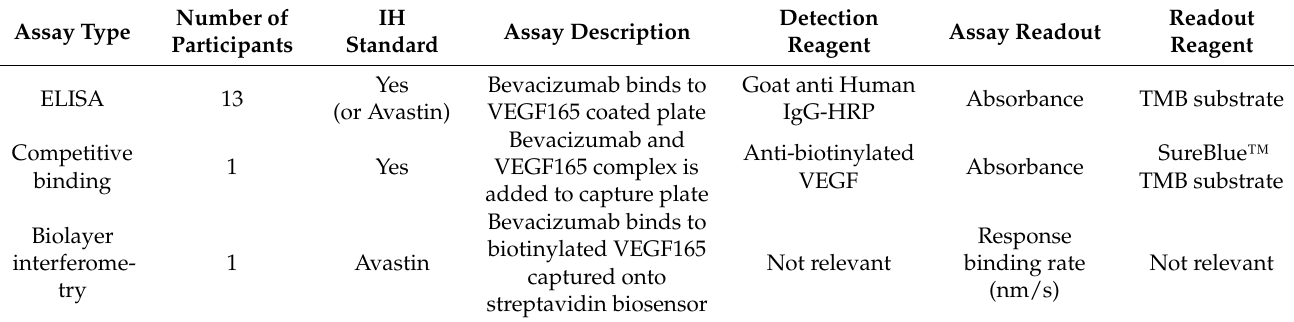
Table 5. Summary of binding assays employed in the collaborative